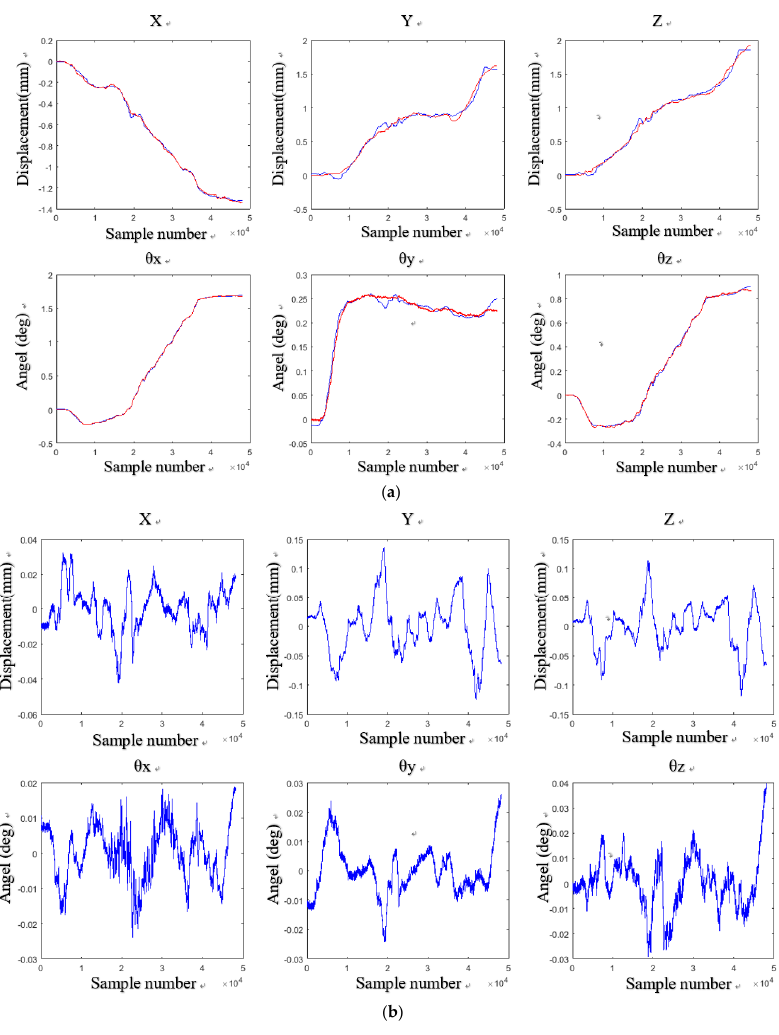
Figure 11. Six DOF measurement results and errors of the wafer stage at the first test: ( a ) six DOF measurement results; ( b ) six DOF measurement errors.